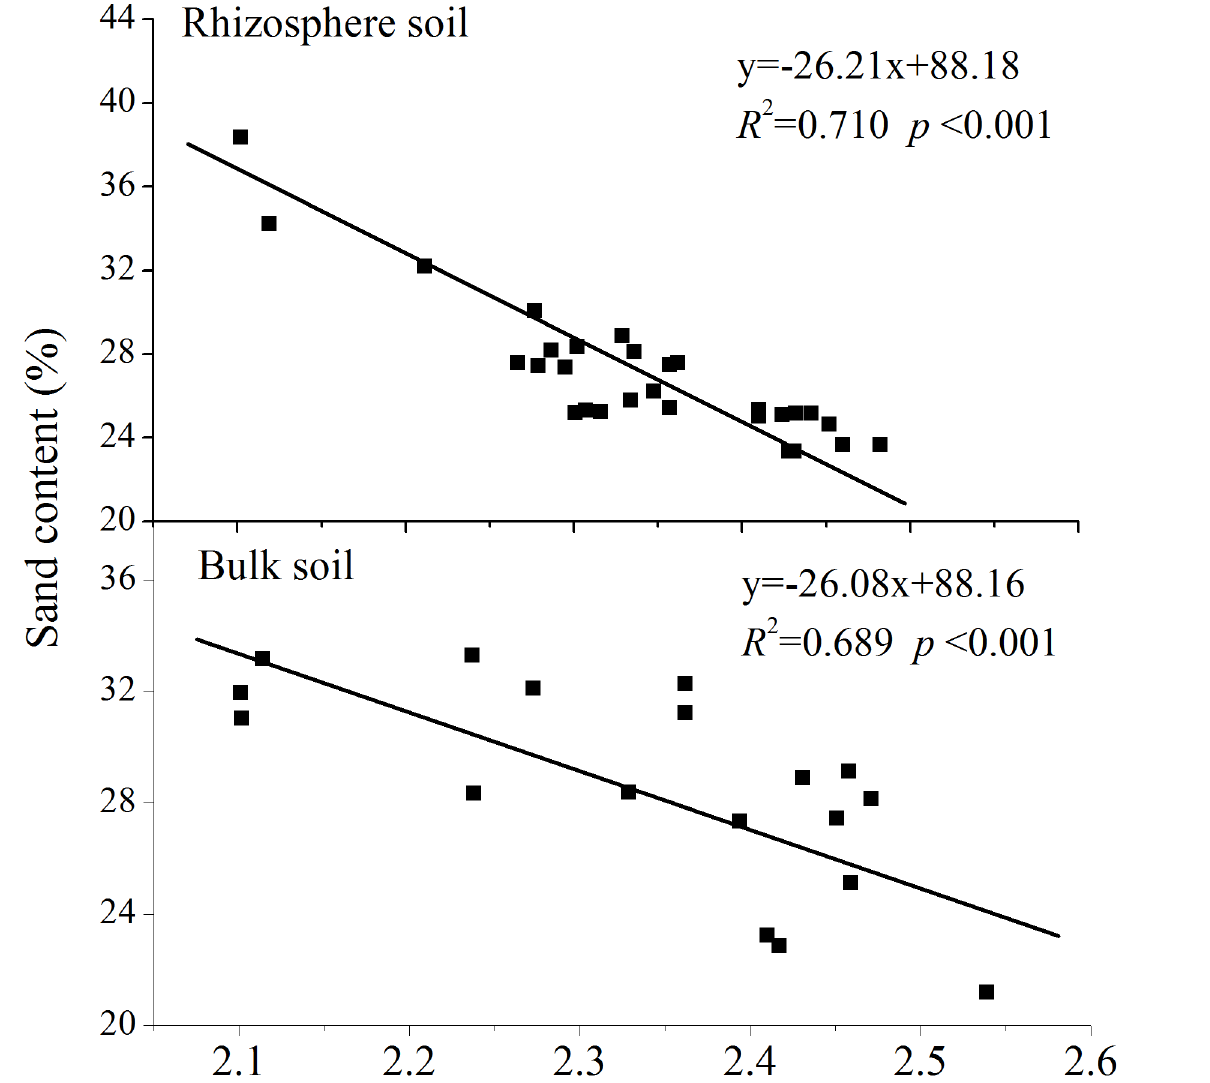
Fig 5. Relationships between fractal dimension and soil sand